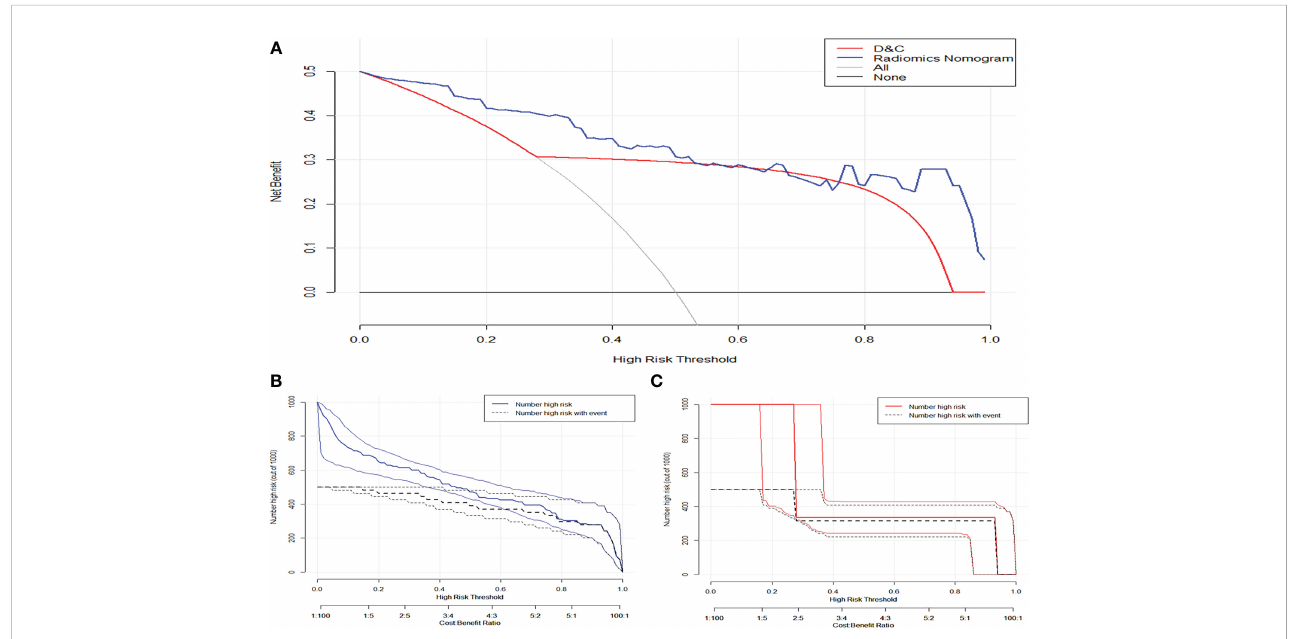
FIGURE 6 (A) The clinical decision curve demonstrated that nomogram has higher net bene fi ts than preoperative curettage at a threshold probability of 0 – 0.47 and > 0.67. The solid blue and orange lines in fi gures (B) and (C) represent the clinical impact curves of the nomogram and the actual preoperative DC, respectively. The black dashed line represents the postoperative pathological results of patients with endometrial cancer, and the closer the solid line is to the black dashed line, the better the prediction